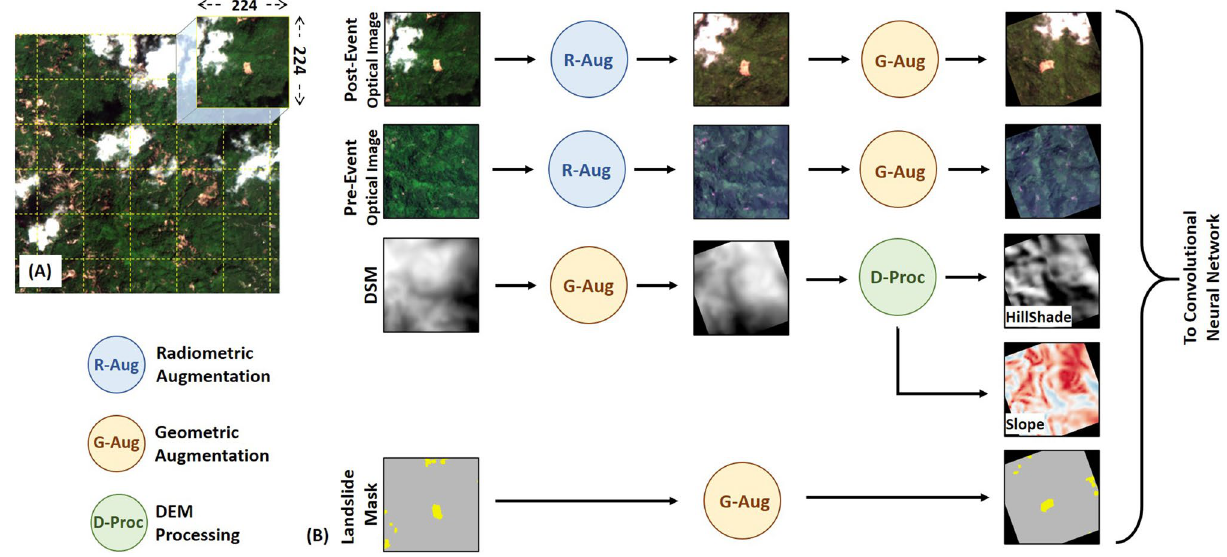
Figure 7. Pre-processing workflow adopted for training of CNN. ( A ) Systematic tiling of input images with 50% overlap. In this study , a tile size of 224 × 224 was used as an input to the CNN. The tile size in display is for representation purposes and does not scale to the actual base resolution used in training the CNN. ( B ) Steps involved in the data-augmentation of input images with their corresponding landslide